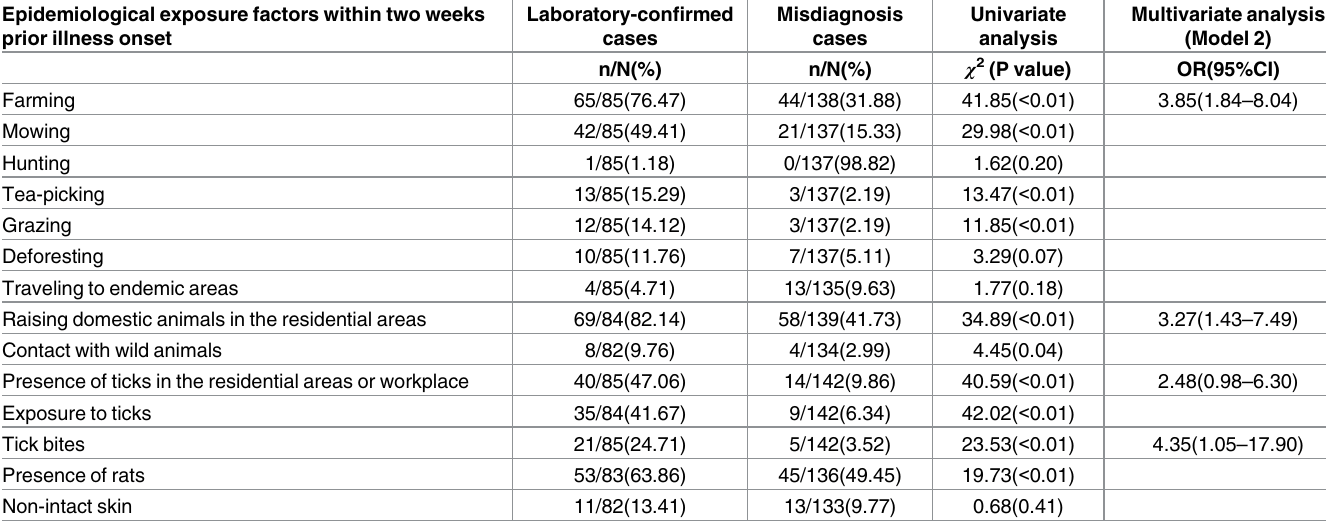
Table 2. Epidemiological exposure factors of laboratory-confirmed cases and misdiagnosis casesin Jiangsu Province, China, 2011–2013. Epidemiological exposure factors within two weeks prior illness